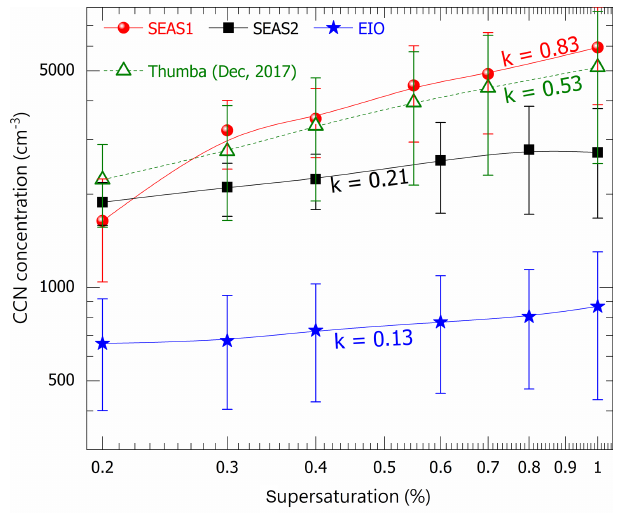
Figure 3. Mean CCN number concentration with the standard de- viation at different supersaturations over the northern Indian Ocean (SEAS1, SEAS2 and EIO) during ICARB-2018. The CCN spectra measured at a coastal station, Thumba, are also shown in the figure for comparison. The graph is shown on a log–log scale.